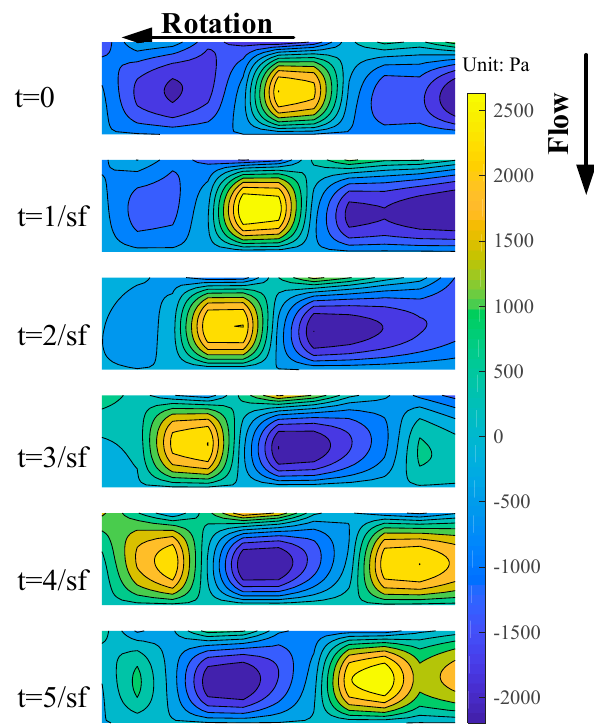
Figure 16. Casing wall dynamic pressure field.